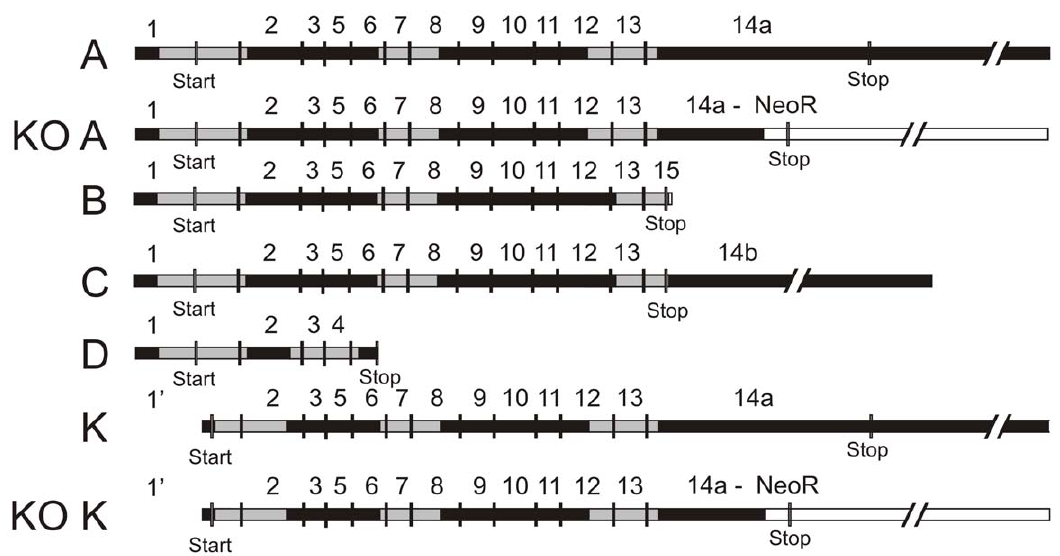
Figure 2. Gene map of the P2X7 receptor isoforms. The map is made according to the NCBI reference sequences. Exons are numbered and start/stop codon are marked. The map illustrates the potential mRNA isoforms that detected in mouse PSCs. These are marked in light grey for both WT and KO samples. Expected KO isoform A and K hybrids are also depicted, with the NeoR cassette inserted in white and the inserted early stop codon labeled.